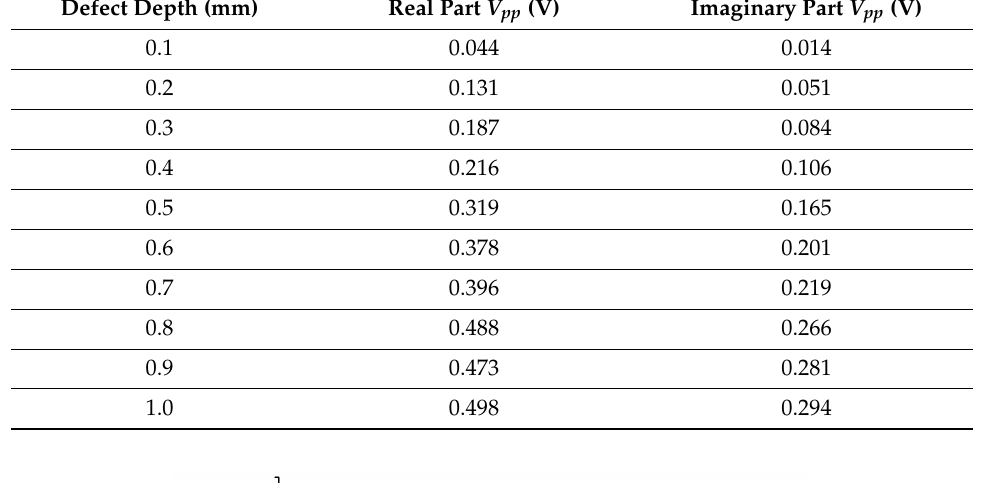
Table 2. Real and imaginary part output from probe A of 1-mm length but di ff erent depth defects. Defect Depth (mm) Real Part V pp (V)